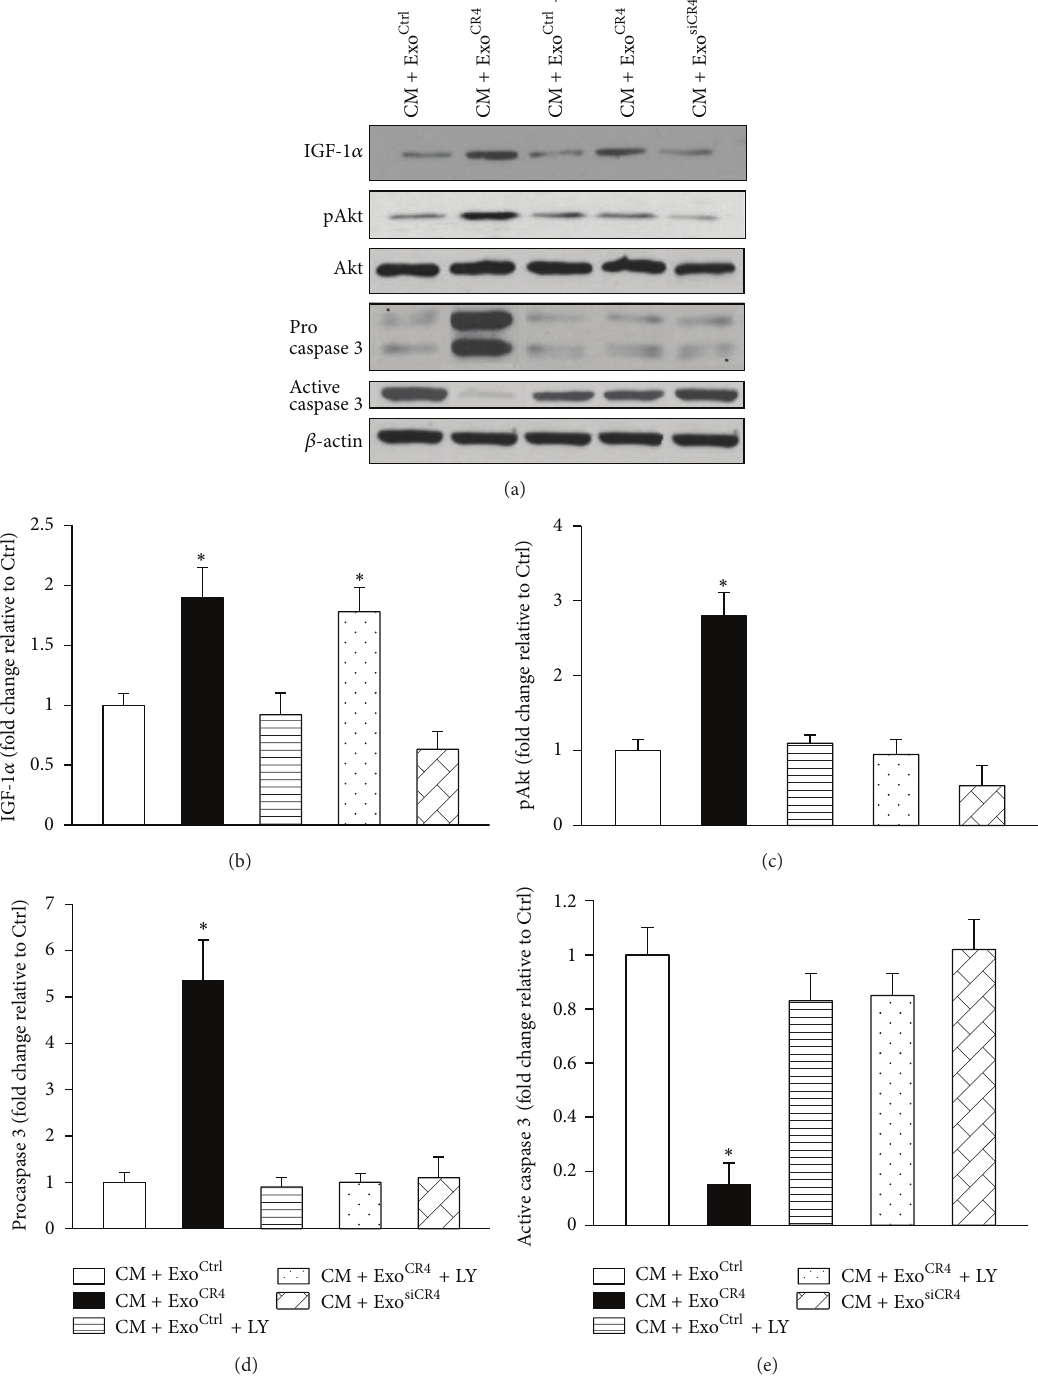
Figure 4: The expression of Akt signaling pathway related genes in CM with various exosome treatments. (a) The expression level of pAkt, IGF-l 𝛼 , procaspase 3, and active caspase 3 in CM was analyzed by Western blotting. ((b)–(e)) Quantitative data of pAkt, IGF-l 𝛼 procaspase 3, and active caspase 3 in CM. ∗ 𝑃 < 0.05 versus CM + Exo ctrl . All values expressed as mean ± SEM, 𝑛 = 6 for each